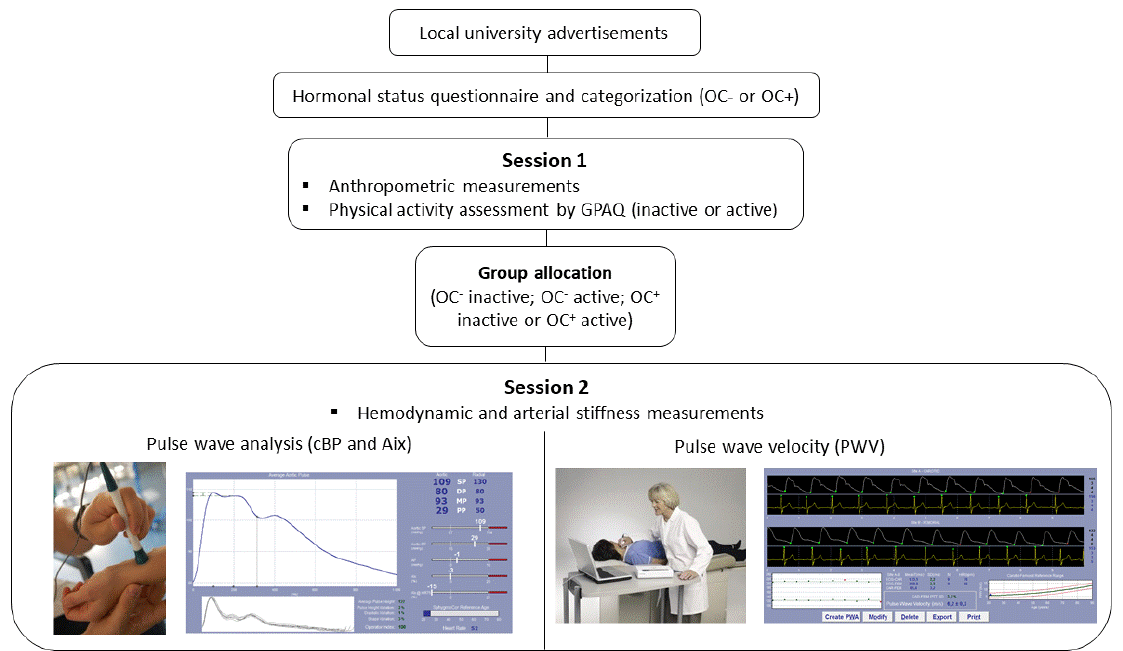
Figure 1. Enrollment of the study participants and study design.